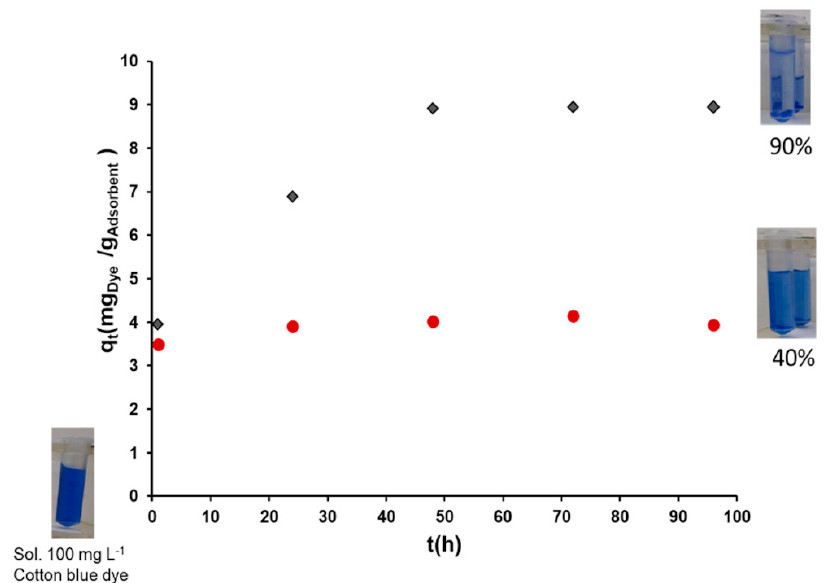
Figure 6. Cotton blue dye adsorption kinetics at pH 5 and 30 °C: Unmodified cellulose (red spheres) and Cel-Asp-N-deprotected (black diamonds).